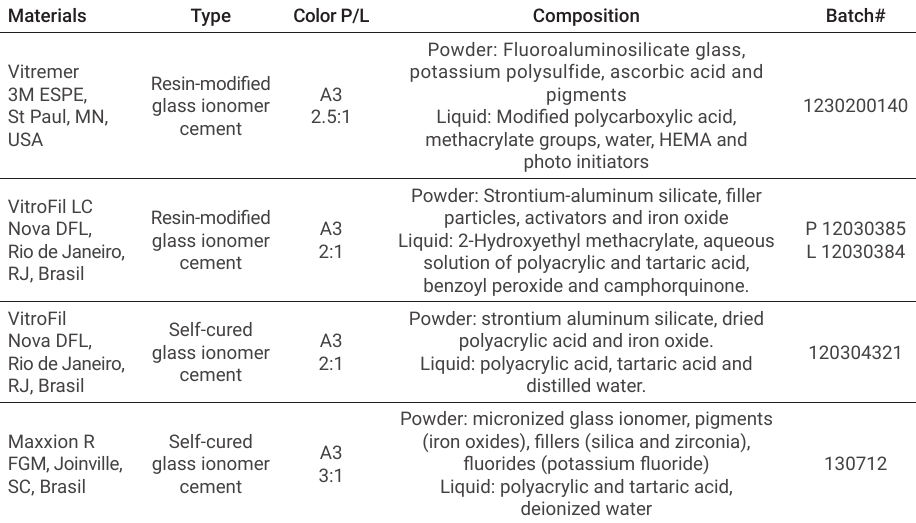
Table 1. Characteristics of glass ionomer cement materials analyzed in this study.